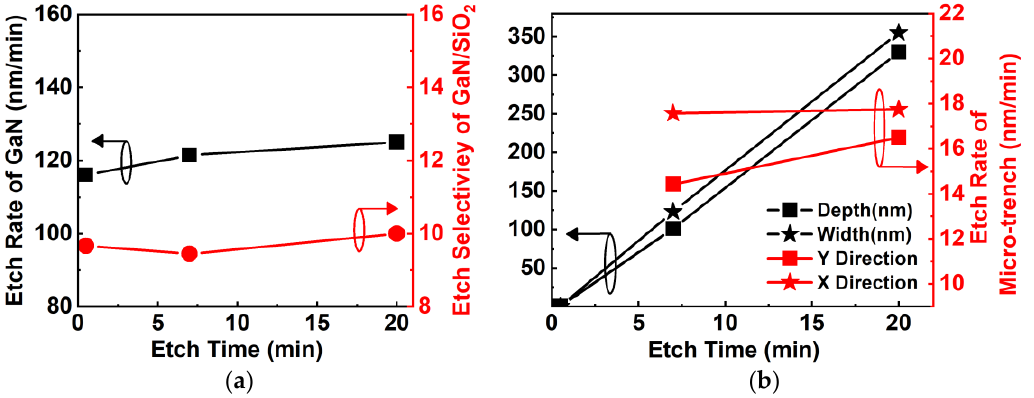
Figure 7. ( a ) Etching rate of GaN and etching selectivity of GaN over SiO 2 as a function of etching time. ( b ) The effect of etching time on the depth and width of the microtrench, and the etching rates of the microtrench in the X and Y directions.